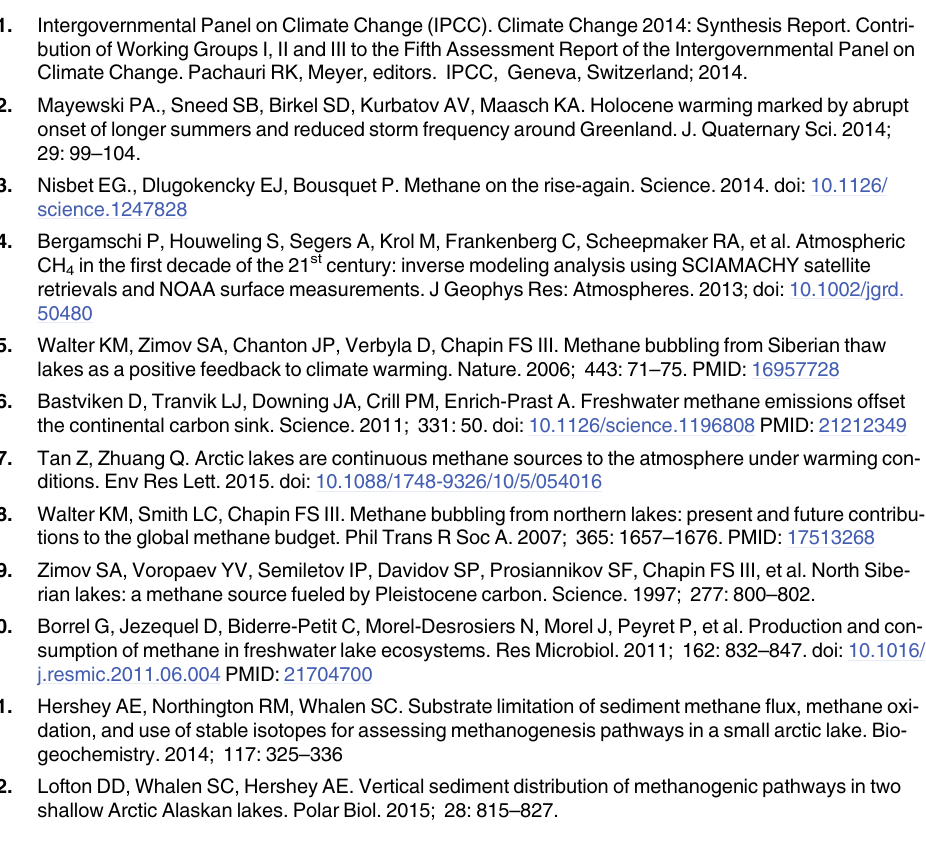
S2 Table. Chemical data from Greenland lakes sampled during summer 2014. Specific details related to analytical techniques may be found in the Materials and